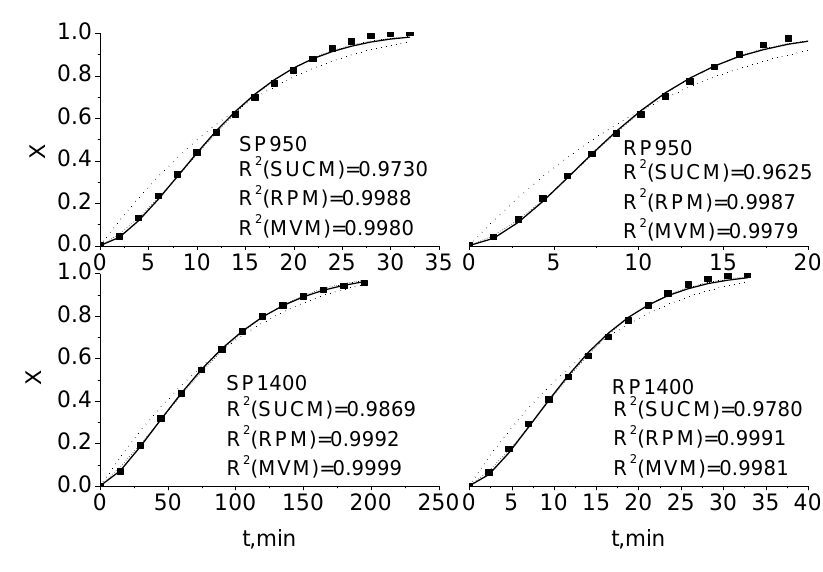
Figure 1. Carbon conversion versus gasification time for coal char gasification at the gasification temperature of 950 °C. Experimental data ( ■ ); SUCM (  ); RPM(---); MVM (—).